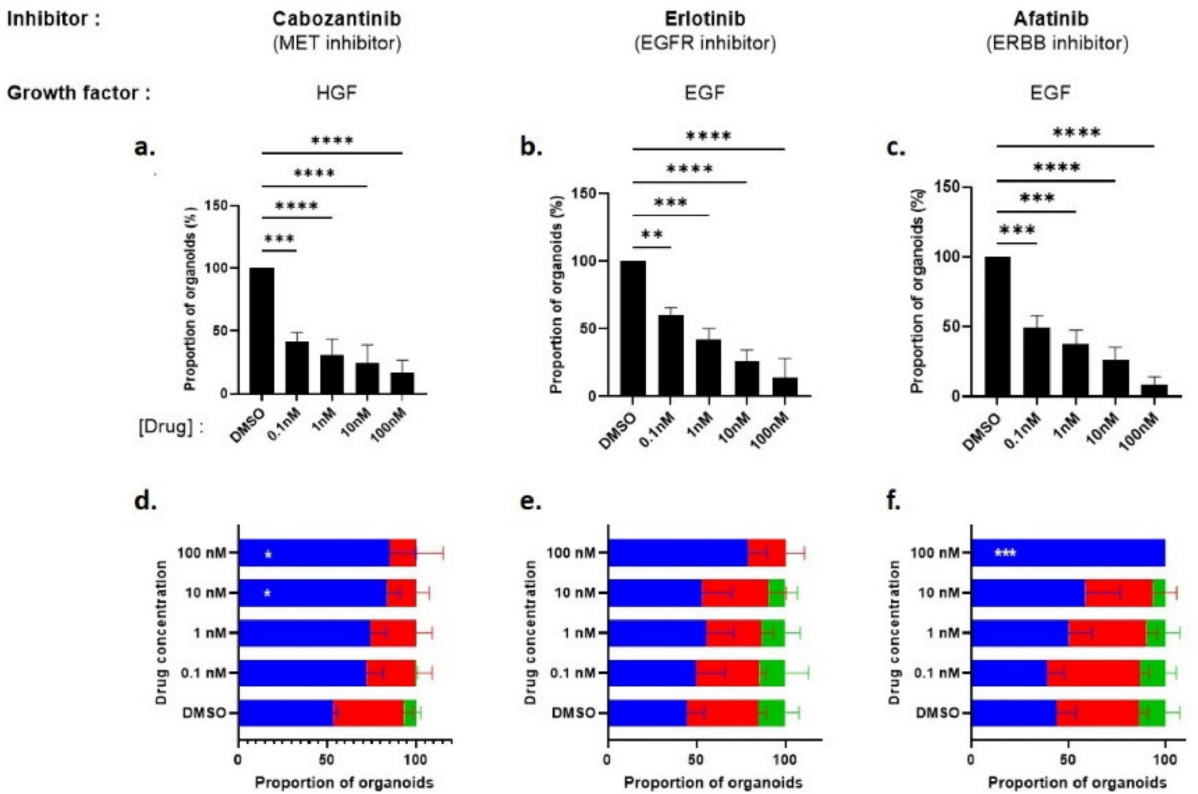
Figure 8. Impact of EGFR/ERBB4 and MET pharmacological inhibitors on the number and size of organoids generated from PTEN-null mouse LSC med cells. Dose–response effect of